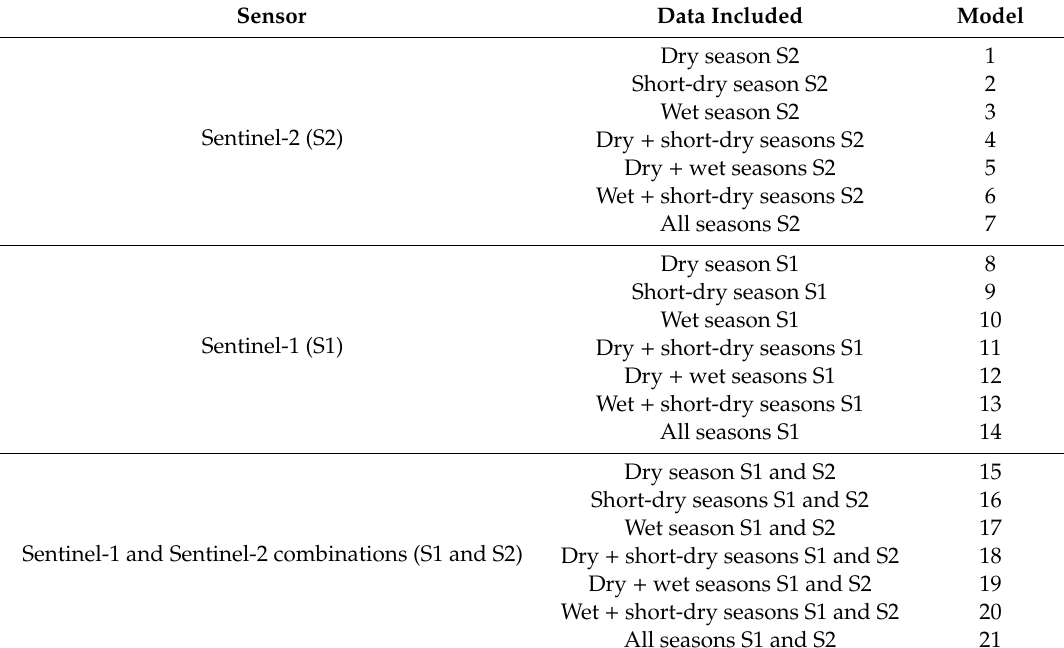
Table 2. The 21 combinations of the models tested.